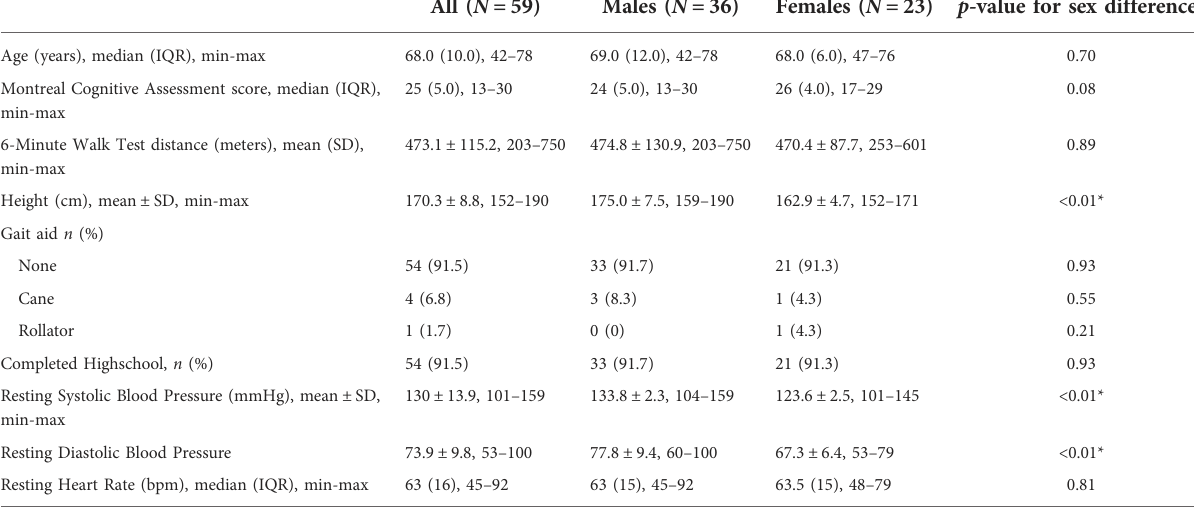
TABLE 1 Participant demographics for full sample ( n =59) and disaggregated by sex. All ( N = 59) Males ( N = 36) Females ( N = 23) p -value for sex differences